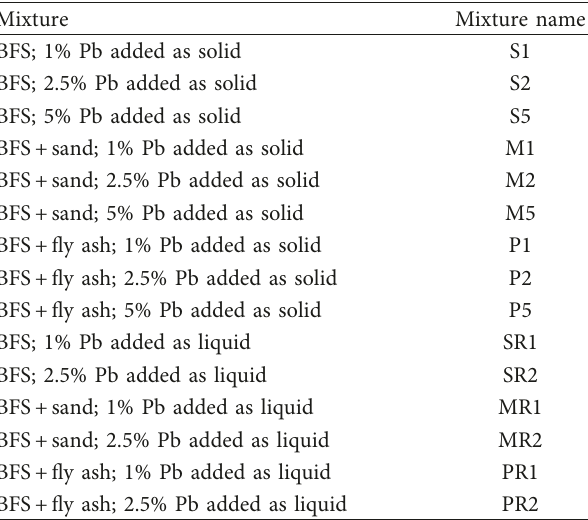
Table 2: The nomenclature of samples.